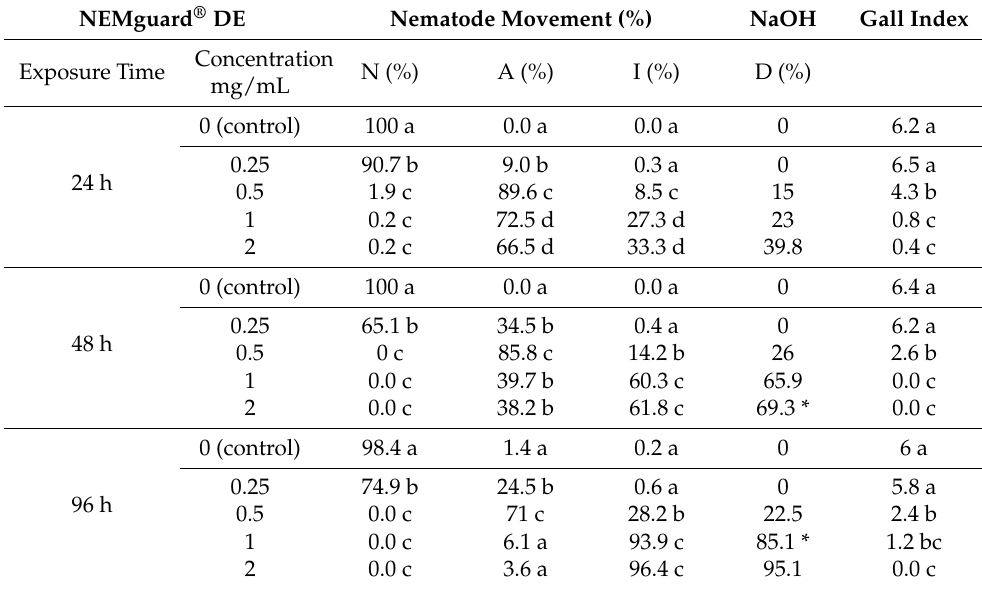
0.0 c 96.4 c 95.1 0.0